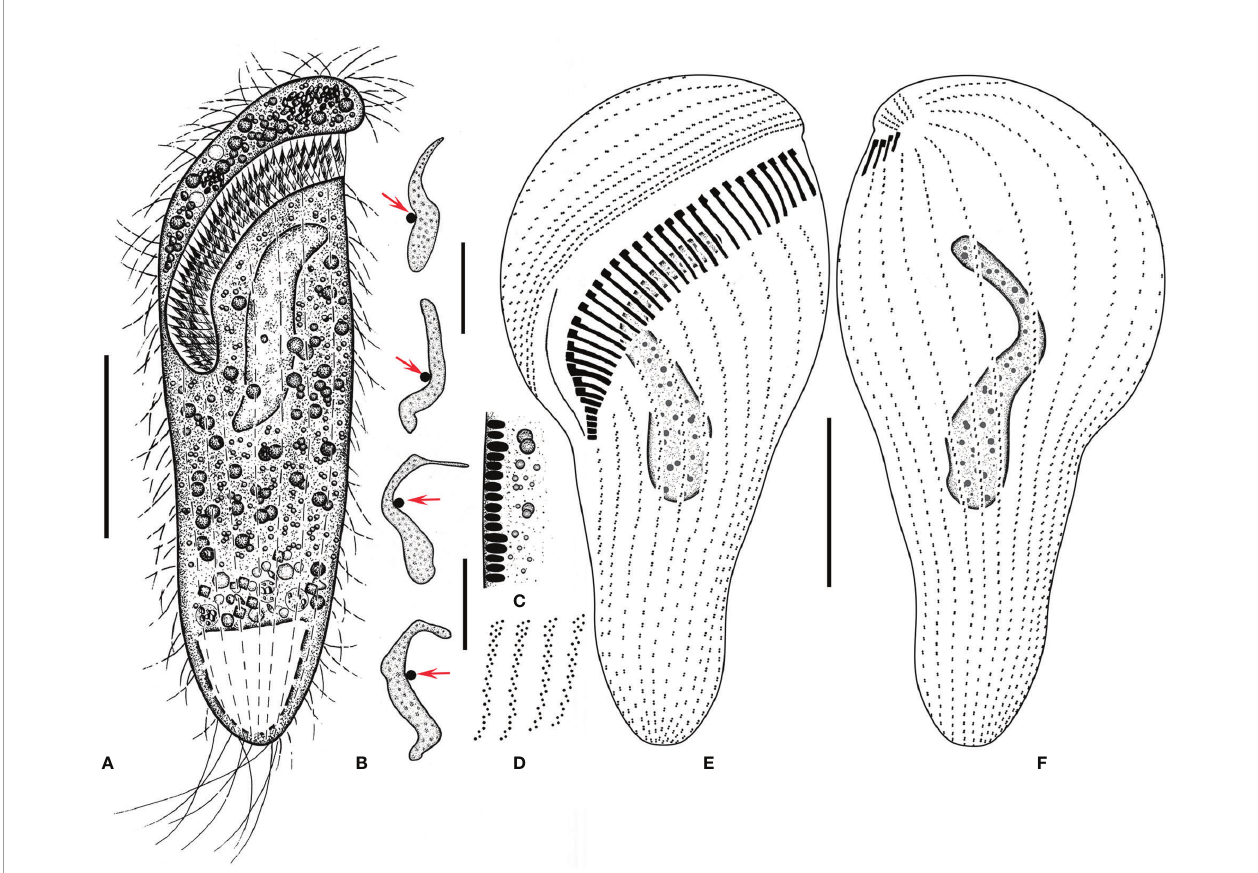
FIGURE 2 | Metopus paraes sp. n. from life (A, C) and after protargol staining (B, D – F) . (A) Ventral view of a representative individual, showing body shape. (B) Different shapes of macronucleus, arrows showing micronucleus. (C) Cortical granules from lateral view. (D) Structure of membranelles from the mid-portion of the adoral zone. (E, F) Ventral (E) and dorsal (F) views of the holotype, showing dome kineties, perizonal stripe, adoral membranelles, paroral membrane, and other somatic kineties. Scale bars: 30 m